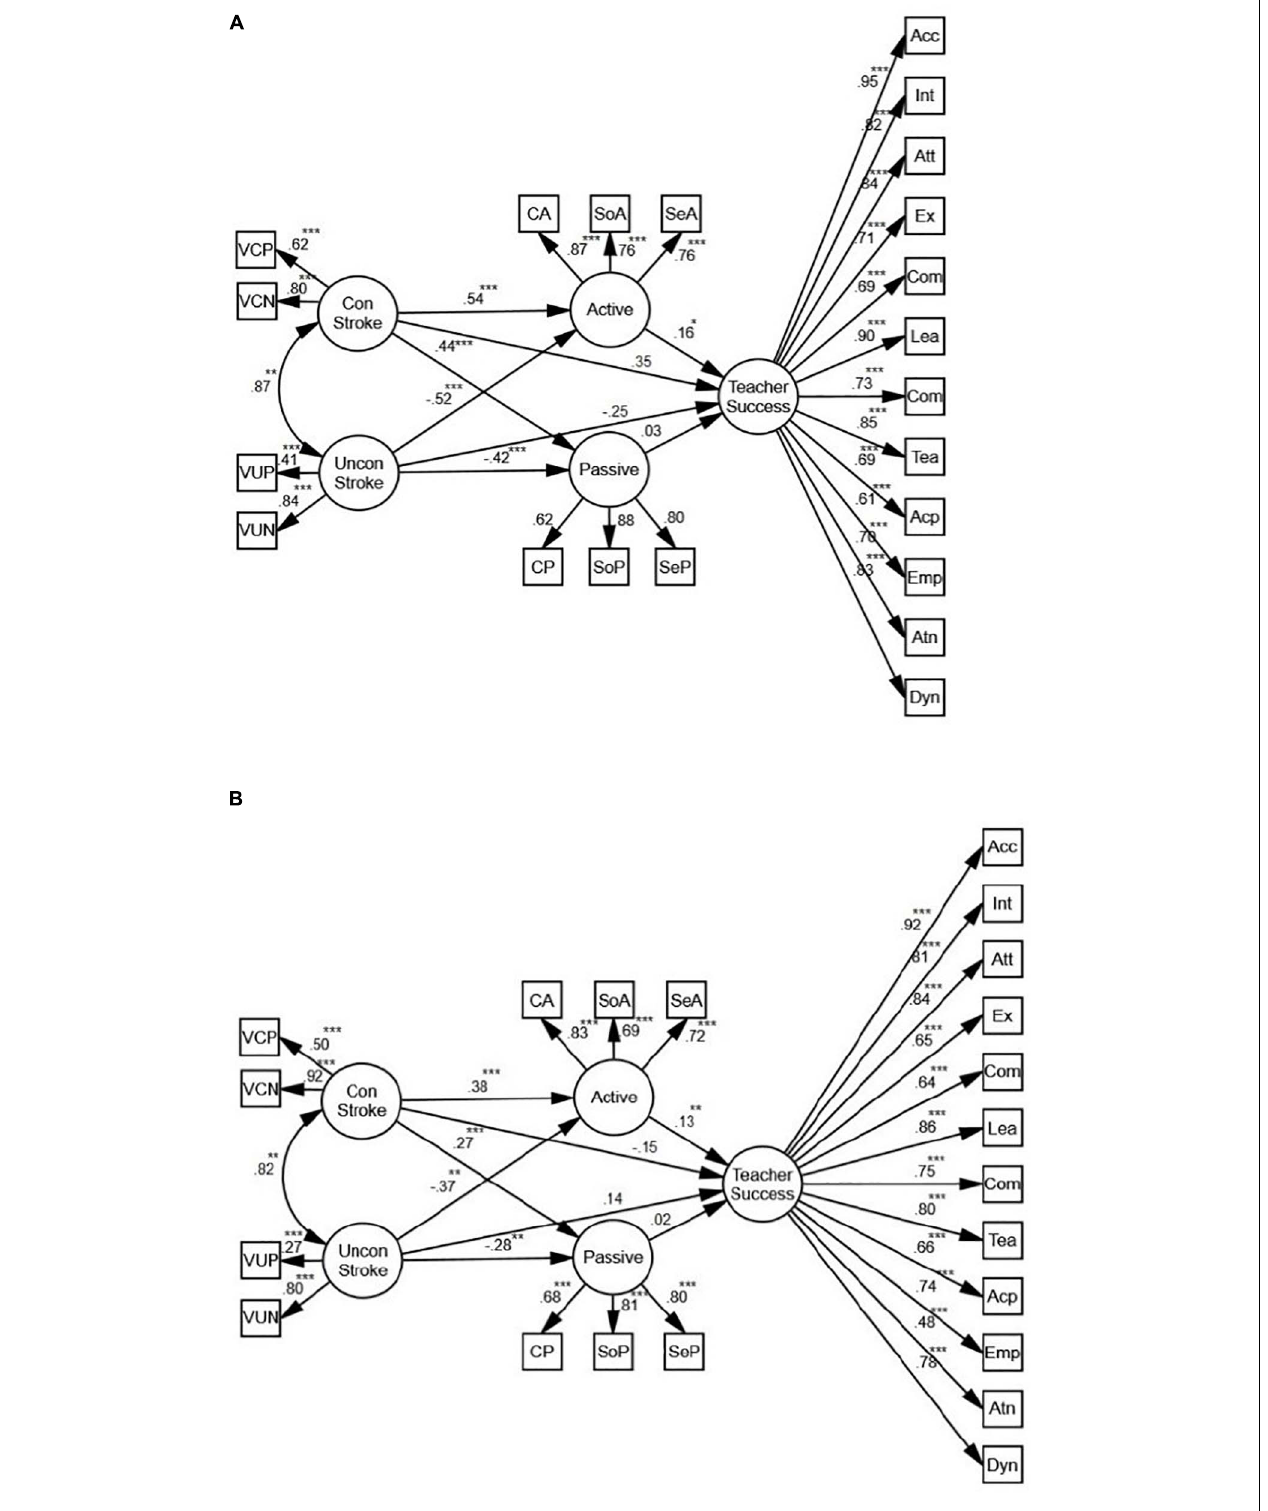
FIGURE 9 | (A) The schematic representation of the relationships between conditional (con) and unconditional (uncon) stroke, active and passive motivation, and teacher success (Females). (B) The schematic representation of the relationships between conditional (con) and unconditional (uncon) stroke, active and passive motivation, and teacher success (Males) (* p < 0.05, ** p < 0.01, *** p < 0.001).